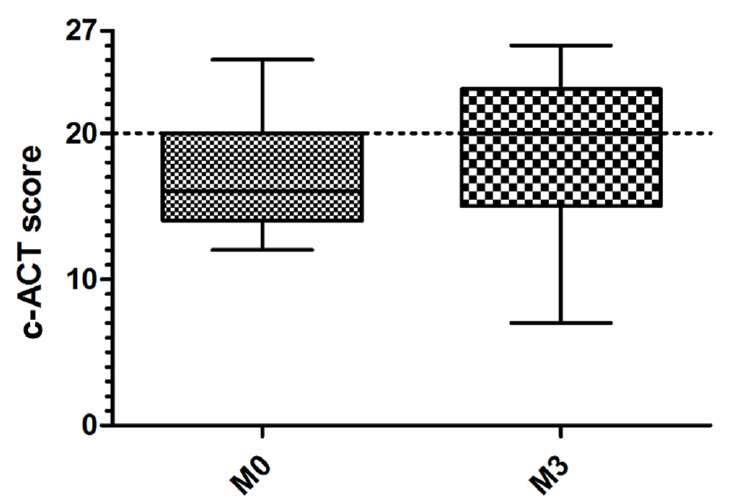
Figure 5. c-ACT (Childhood Asthma Control Test) score at the beginning (M0) and at the end (M3) of the study. The c-ACT score ranges from 0 (worst score) to 27 (best score). Score ≥ 20 indicates good asthma control. Boxes range from first to third quartile. The horizontal line across the box represents the median. The whiskers go from each quartile to the minimum and maximum.